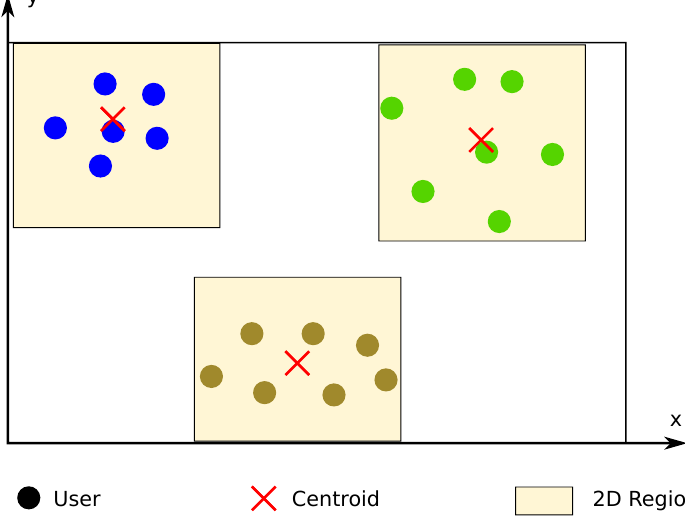
Figure A1. 2D regions for initial population creation ( D =